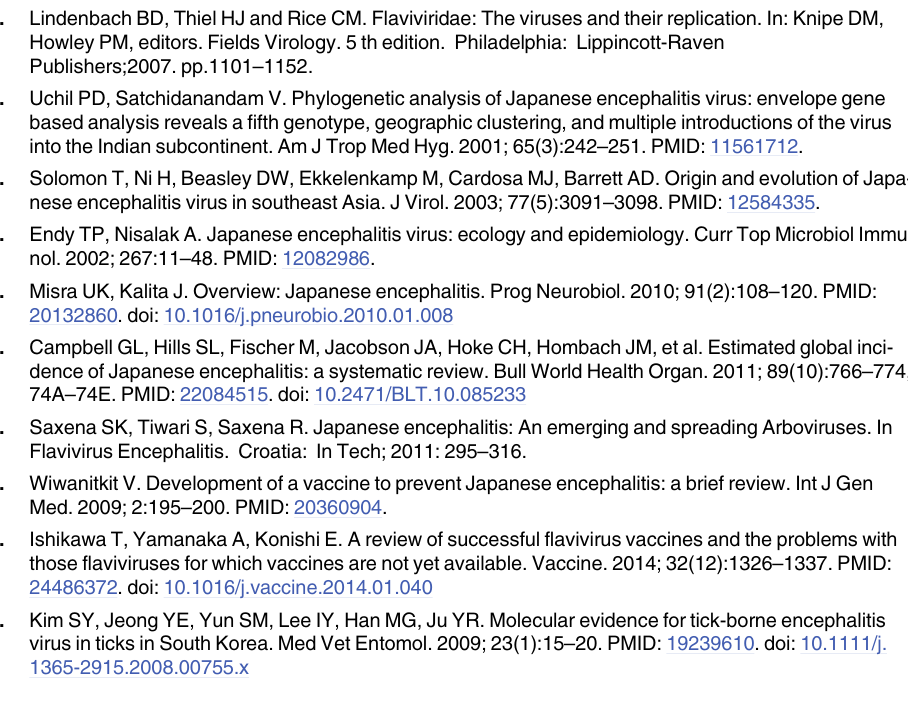
S1 Table. Quality assessment of the plaque reduction neutralization test. S2 Table. Rice cultivation area and the scale of pig farms in Korea in